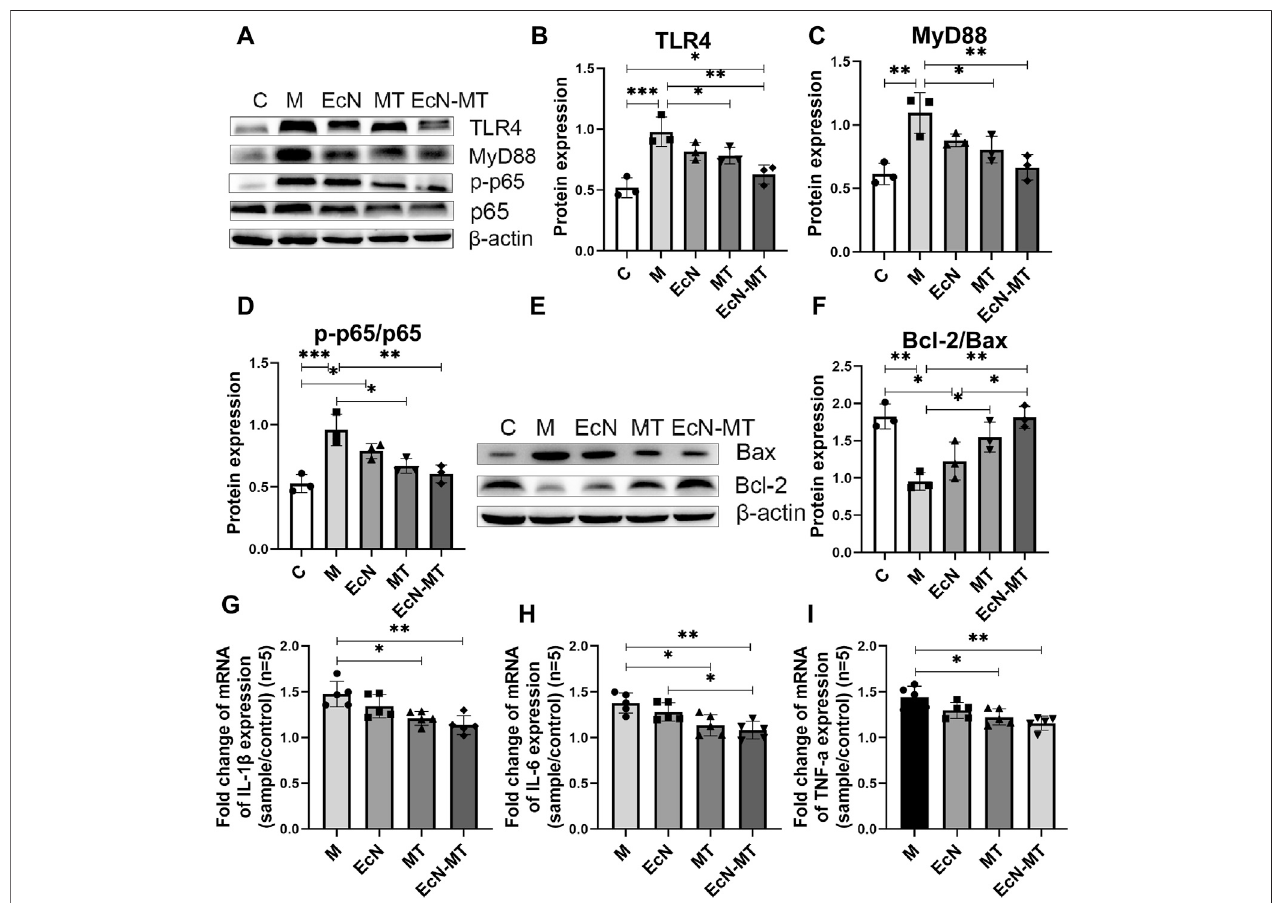
FIGURE3| EcN-MTreducedliverin fl ammationandapoptosis.Valuesarepresentedasmeans±SD( n =3,exceptq-PCRresultsrepeated fi vetimes). (A) Western bloting analysis of TLR4, MyD88, p-p65, p65 expression in liver tissues. The relative expressions of (B) TLR4, (C) MyD88, (D) p-p65/p65 were quanti fi ed by ImageJ. β -actin wasused asaninternal control. (E) Western bloting analysisofBax,Bcl-2 expression inlivertissues. (F) Therelative expressionsofBcl-2/Baxwere quanti fi edby ImageJ. β -actin was used as an internal control. The relative mRNA expressions of (G) IL-1 β , (H) IL-6, (I) TNF- α in liver tissues were detected by q-PCR. * p < 0.05, ** p < 0.01, *** p <